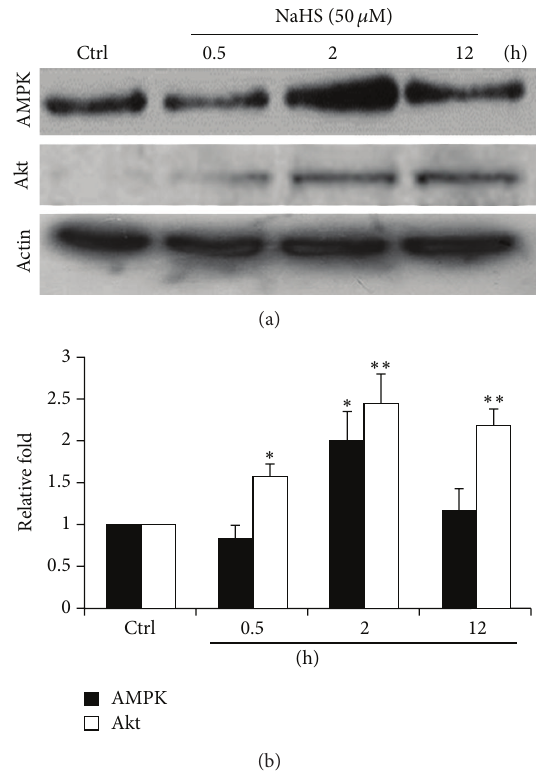
Figure 3: The expression levels of AMPK and Akt in the presence of NaHS. (a) ECs treated with NaHS (50 𝜇 M) for 0.5, 2, and 12 h. The blotted membranes hybridized with AMPK antibody. (b) Relative folds of protein levels shown as means ± S.E. compared to control. Statistical significance ( ∗ 𝑃 < 0.05 ; ∗∗ 𝑃 < 0.01 ) analyzed using Fisher’s